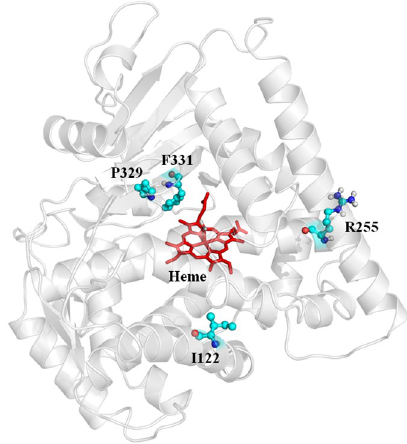
Figure 4. The crystal structure of P450 BM3 WT illustrating the 4 identified positions (I222, R255, P329, and F331) from the two rounds of epPCR. The positions selected are represented as ball and sticks. The heme cofactor is depicted in red sticks.